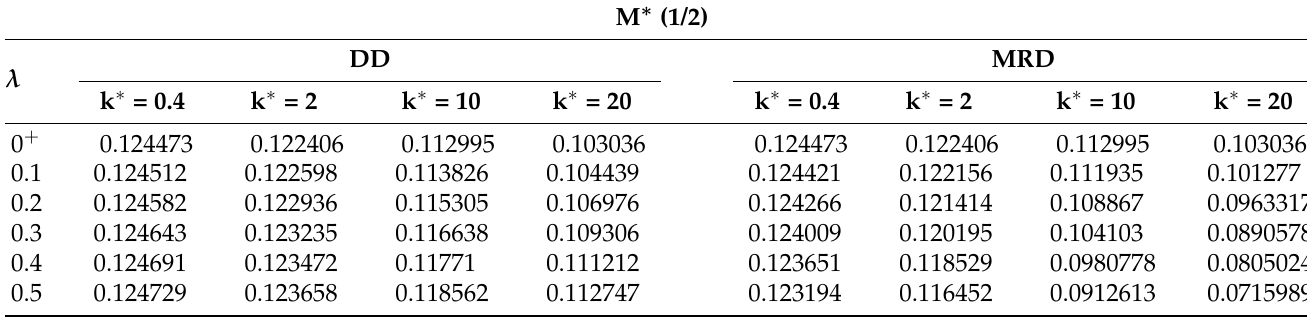
Table 8. Simply supported beam subjected to a non-dimensional uniform load q ∗ y = − 1. Non-dimensional midpoint bending moment M ∗ ( 1/2 ) versus the non-dimensional length-scale parameter λ evaluated by the non-dimensional Winkler parameter k ∗ ∈ { 0.4,2,10,20 } in the DD and MRD